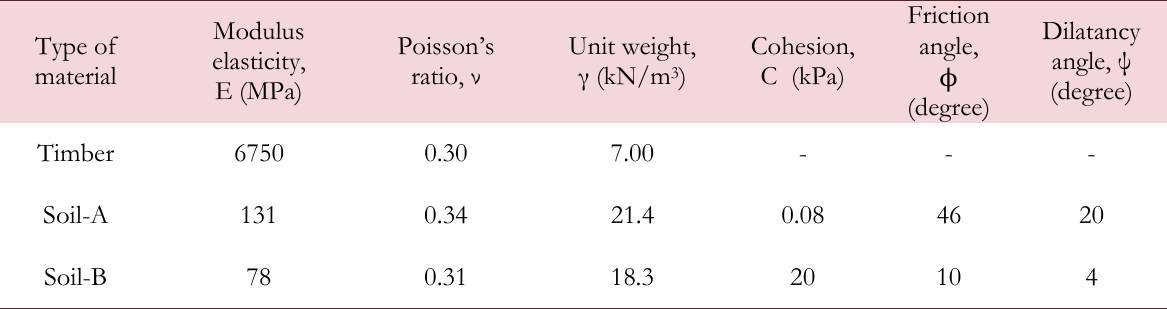
Table 1: Soils and timber mechanical